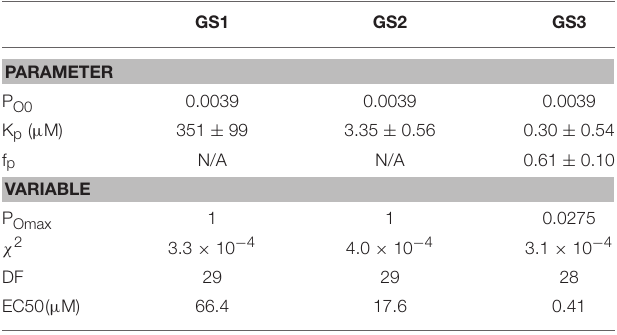
TABLE 1 | Parameters and variables of gating models characterizing interaction between DP cpvtN2 and